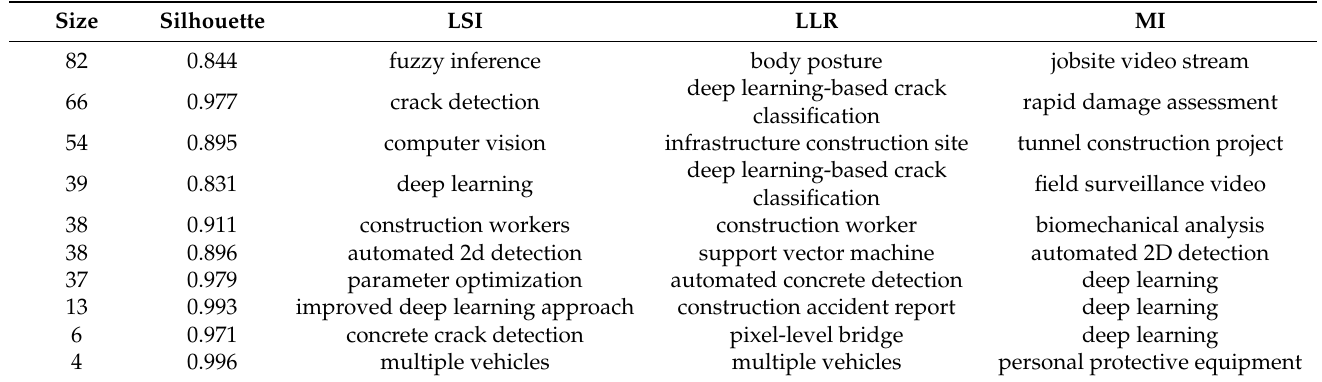
Table 2. Top-ranked clusters derived from three algorithms.